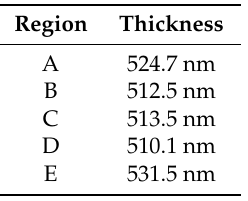
Table 2. The thickness of the MAPbI 3 layer in five areas on large-area thin film.